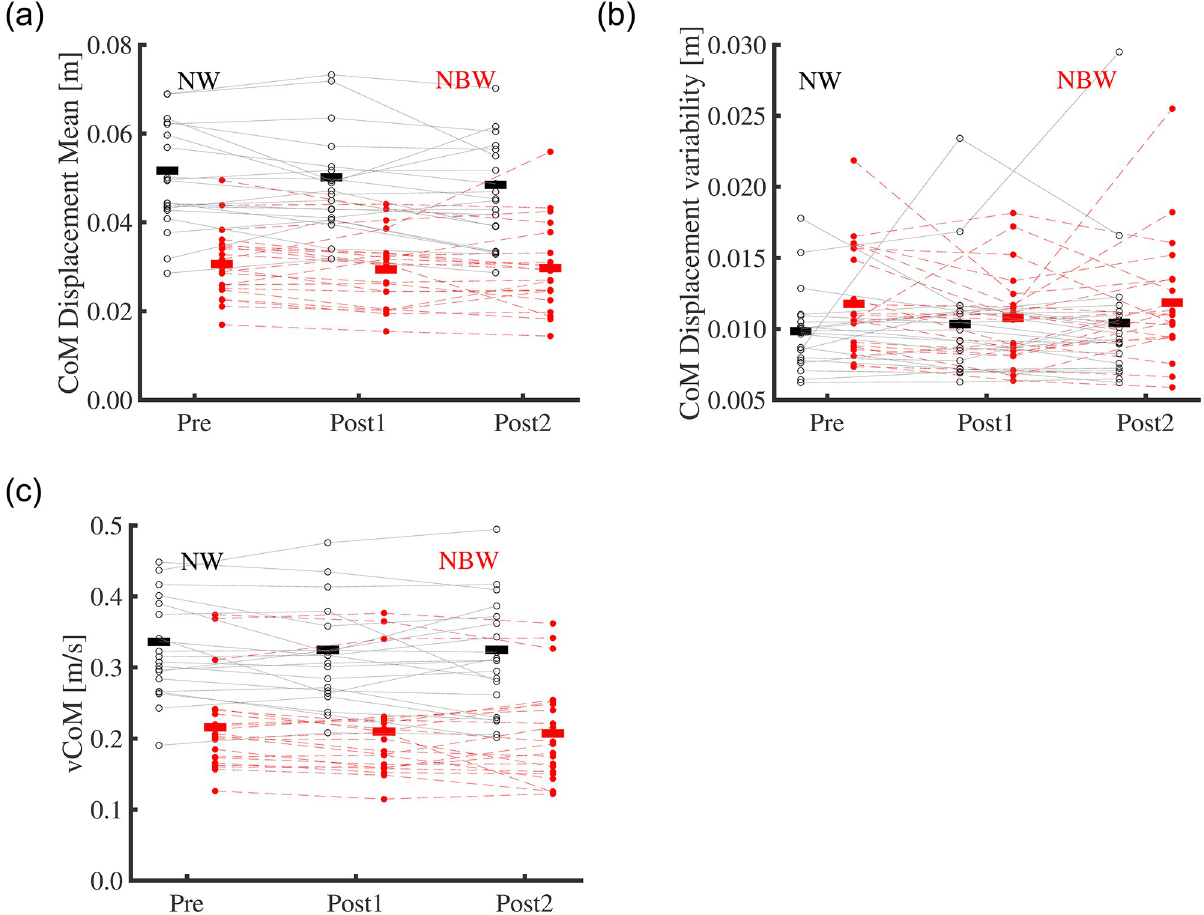
Fig 5. (a) Mediolateral center of mass displacement and (b) variability, and (c) center of mass velocity in narrow-base and normal walking at time- points Pre, Post1, and Post2. Thin lines represent individual subject data. Thick horizontal lines indicate means over subjects. Black, normal walking; red filled-dot, narrow-base